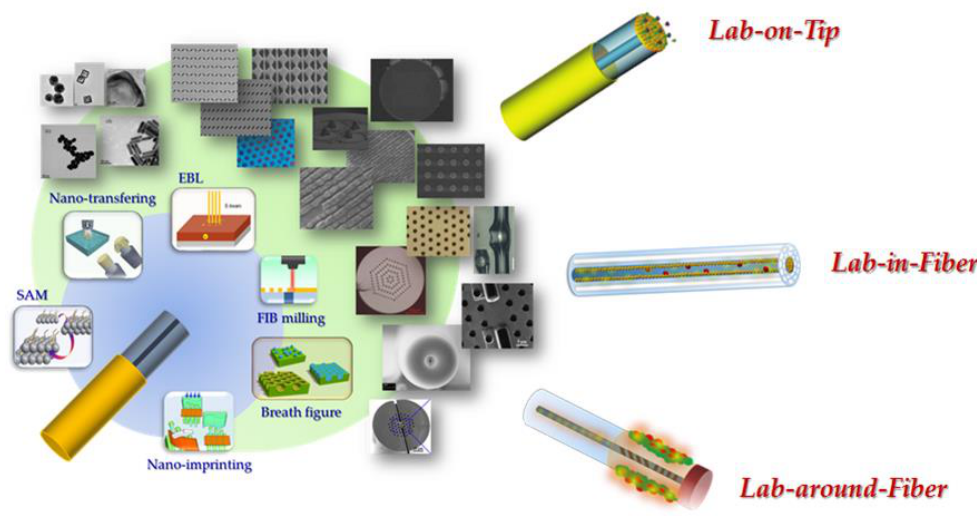
Figure 1. The lab-on-fiber paradigm. Reproduced with permission from Reference [5]. Copyright Wiley-VCH Verlag GmbH & Co., KGaA.